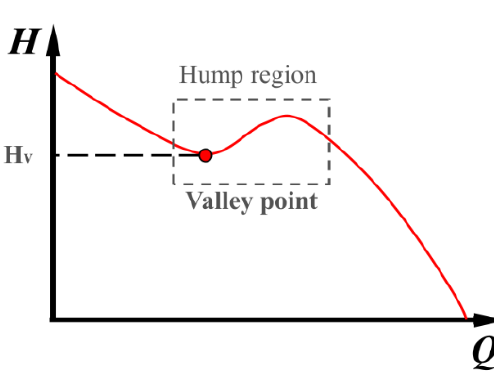
Figure 1. Configuration of the pump turbine model.